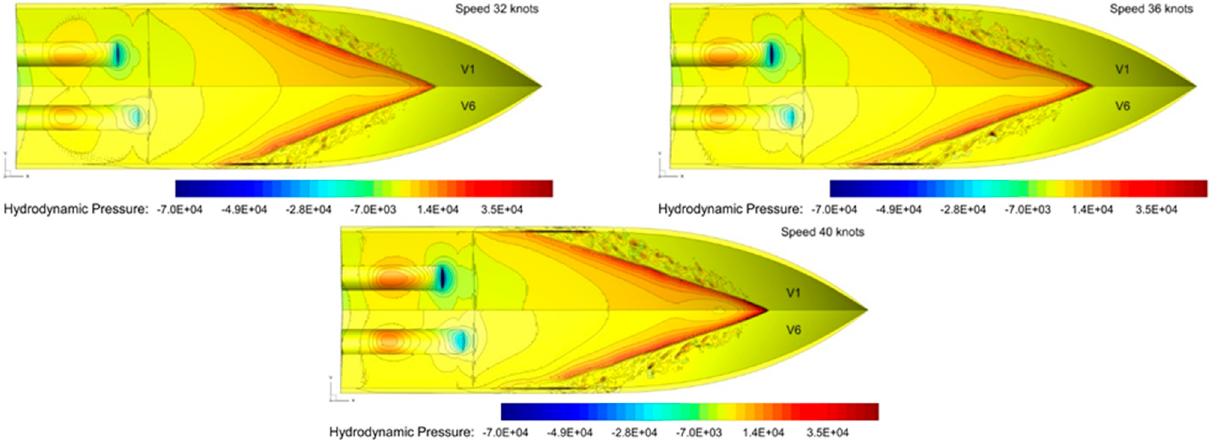
Figure 7. Comparison of pressure distribution on the hull bottom for V1 and V6 at different speeds.